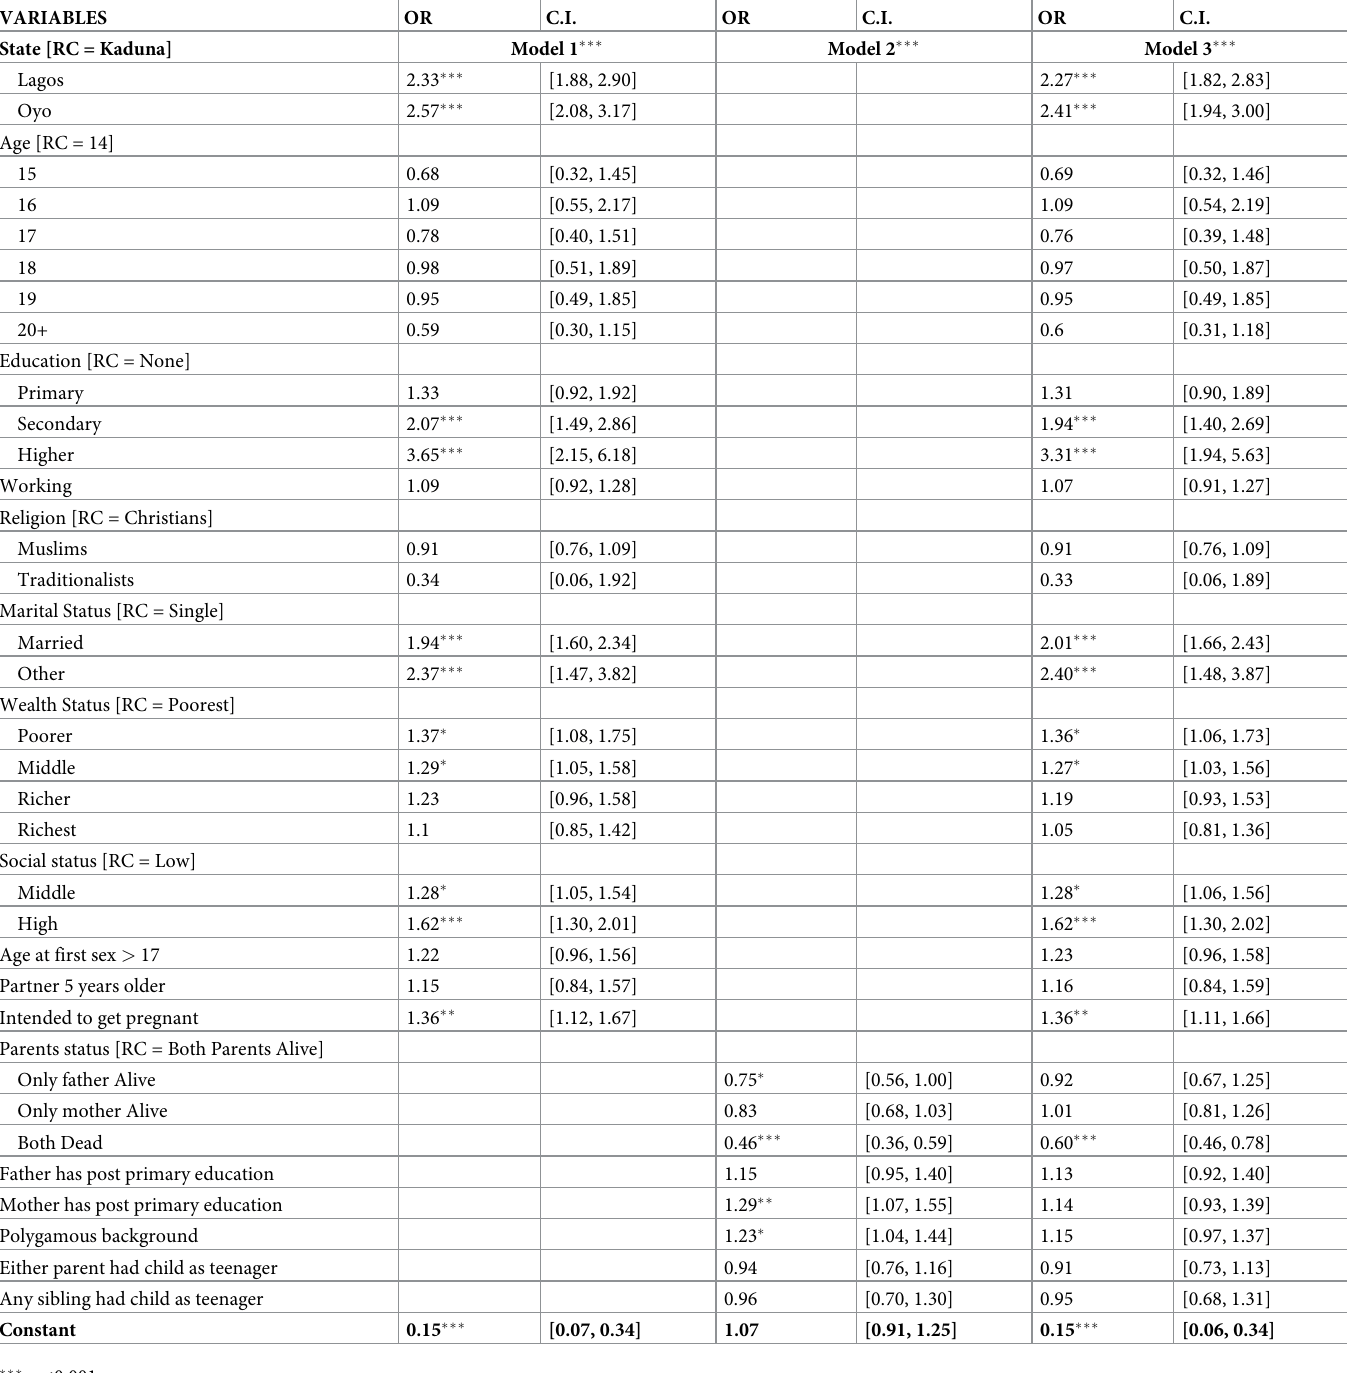
Table 5. Binary logistic regression analysis showing the effect of background and family variables on making at least 4 antenatal visits in facilities with skilled